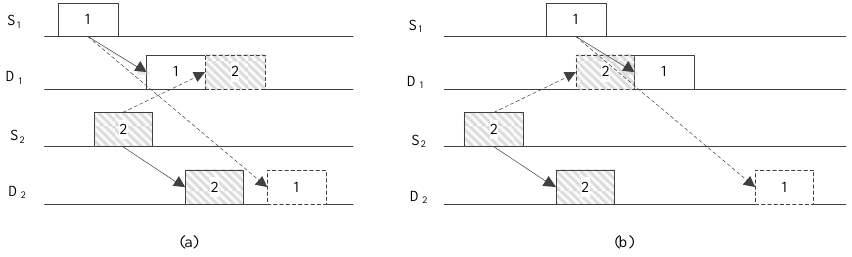
Figure 2. Concurrent transmissions with different sending sequences. ( a ) S 1 sends first; ( b ) S 2 sends